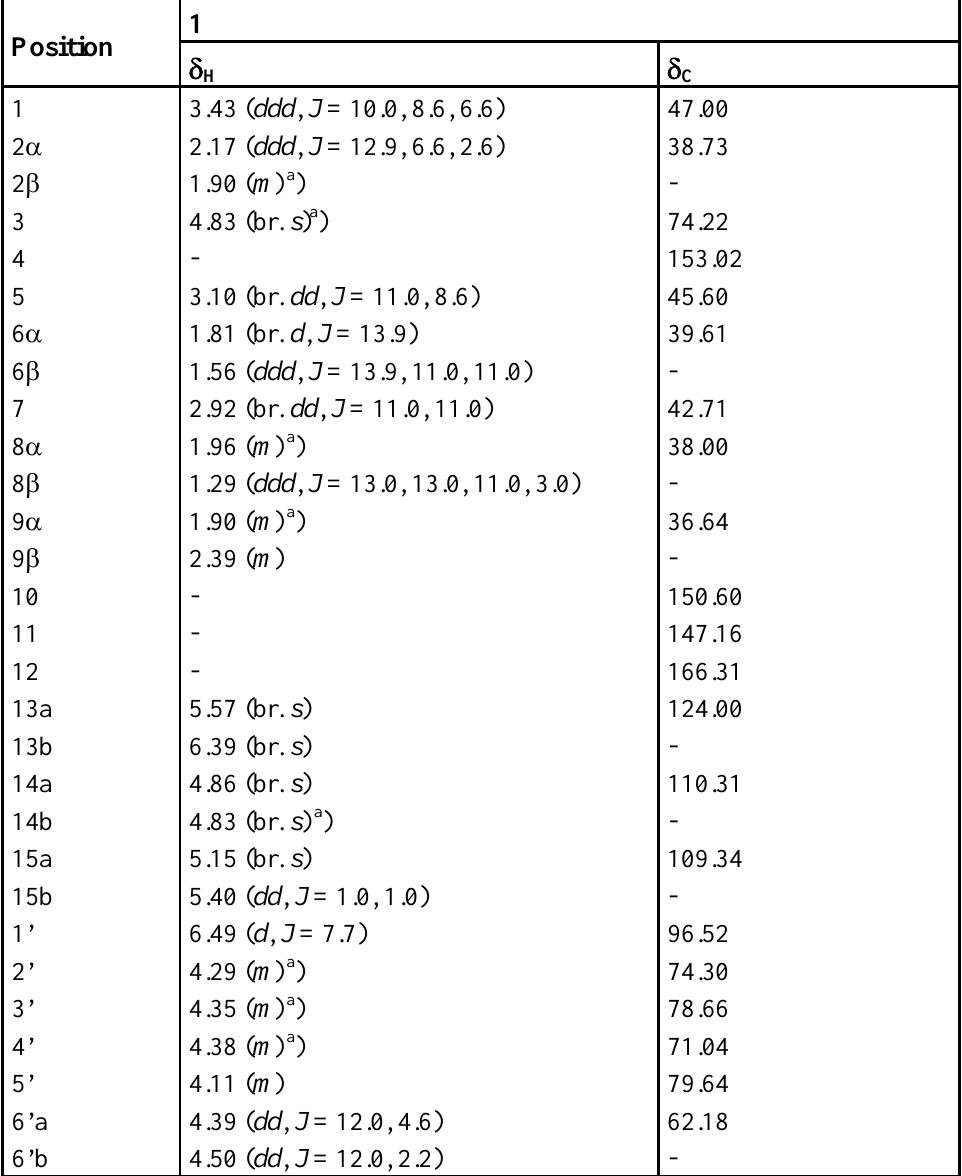
Table 2. 1 H- (500.13 MHz) and 13 C-NMR (125.76 MHz) data of 1 (pyridine- d ppm, J in